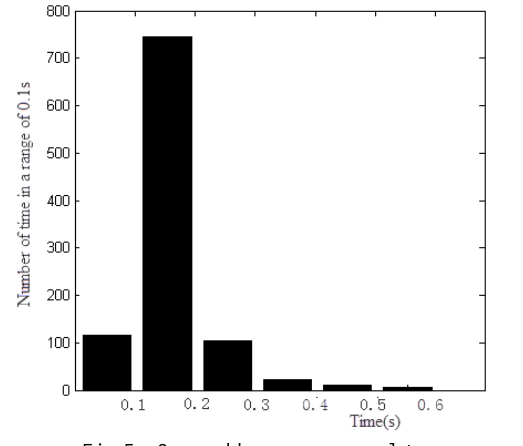
Fig. 5 One subkey recovery on